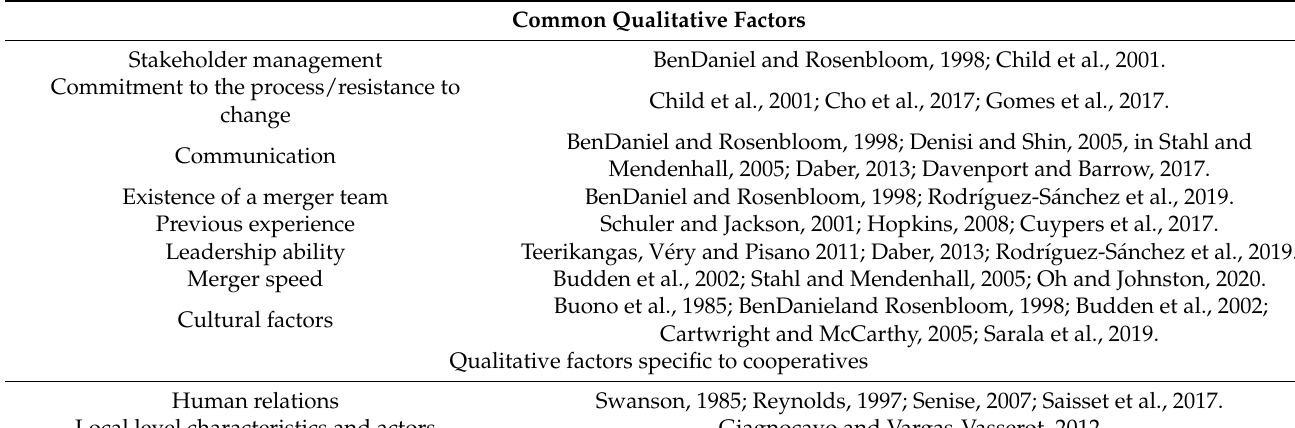
Table 1. Qualitative factors which are relevant in a